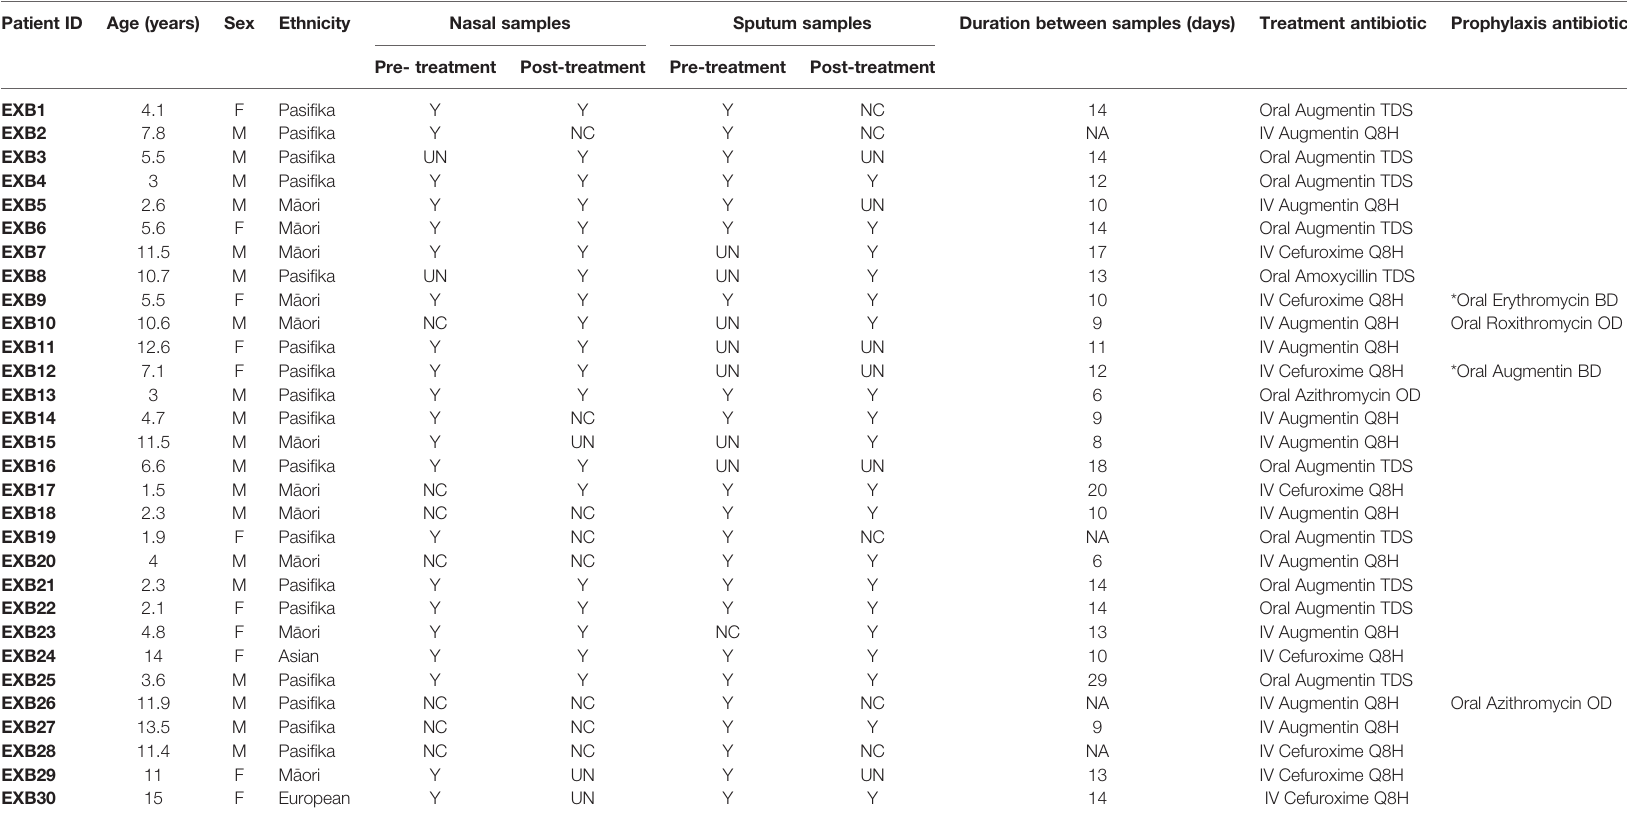
TABLE 1 | Patient sample and demographics